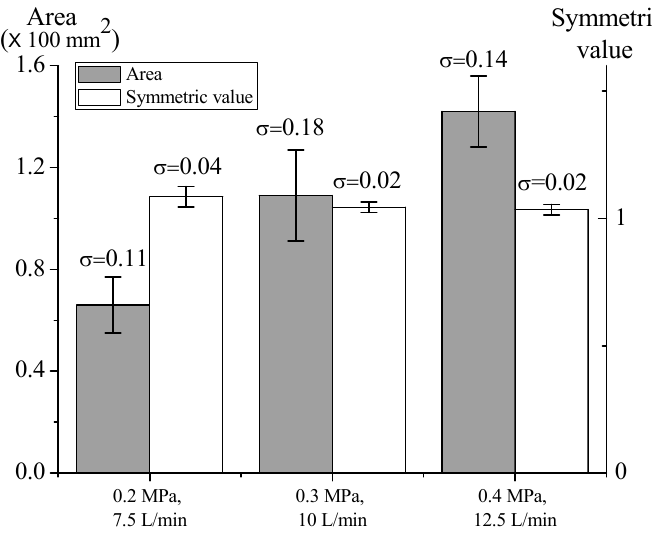
Figure 9. Effects of different pressures and flow rates on particle deposition with mask. Data are shown with mean ± SD ( n = 3).